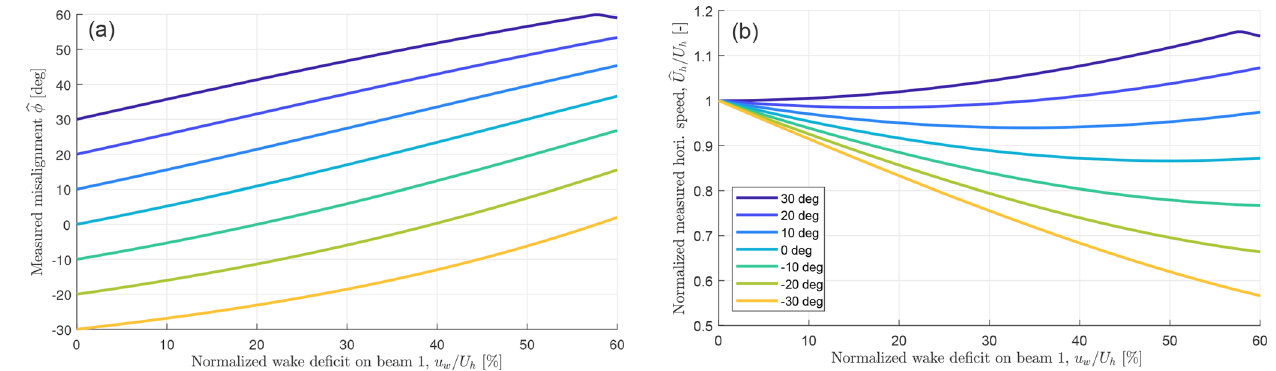
Figure 2. Influence of a streamwise flow speed reduction due to a wake u w at LOS 1 on the lidar estimates of turbine yaw misalignment b φ and horizontal wind speed b U h . The differently coloured lines represent different turbine misalignments φ